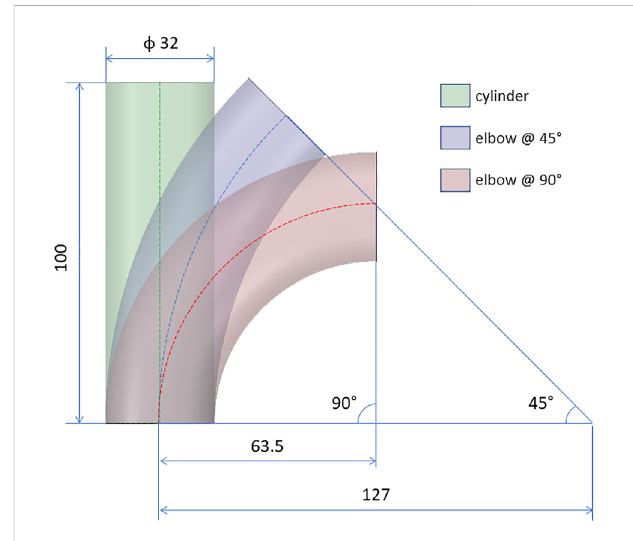
FIGURE 3 Designoftheidealizedgeometriesforthevalidationcases:cylinder and elbows at 45 ° and 90 ° . All quotations are given in mm.